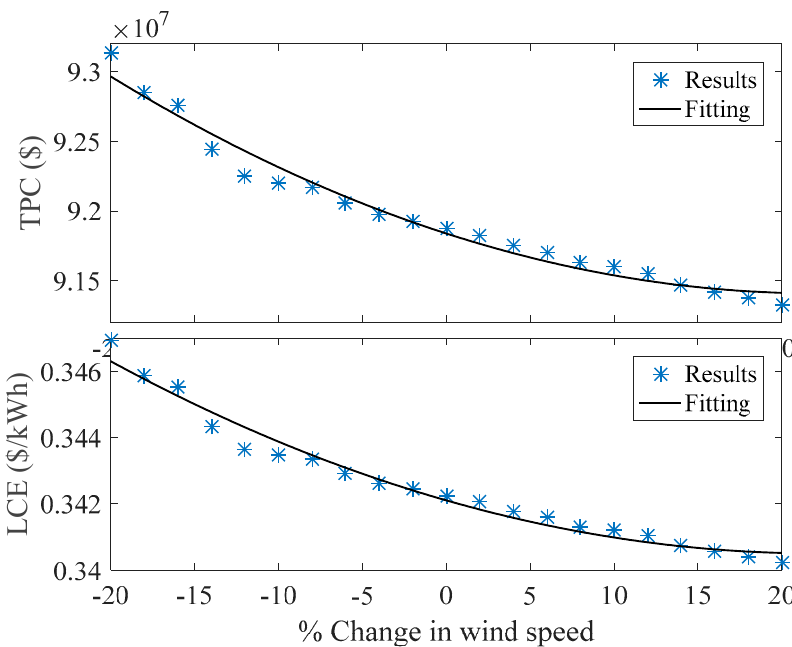
± 20% change in wind speed.